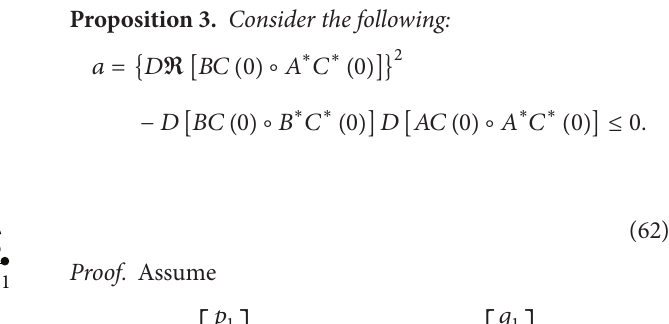
Figure 2: The relationship between entropy and probability for two- level quantum systems.